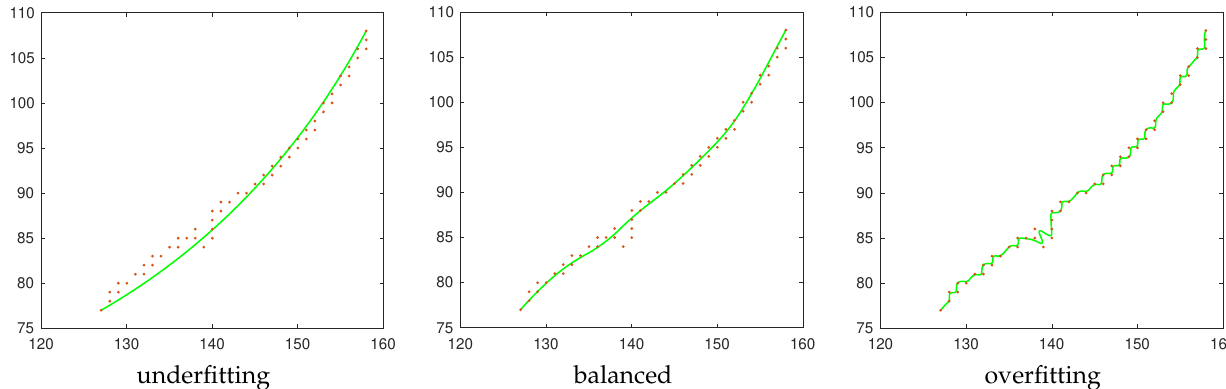
Figure 5. Three approximations for a local tubular neighborhood from Figure 6. In the left image, the local approximation consists of an oversimplification of the input data. In the right image, the local approximation models the training data too well, resulting in unwanted oscillations that reduce the prediction capability on new points. A good balance between under- and over-fitting is displayed in the central